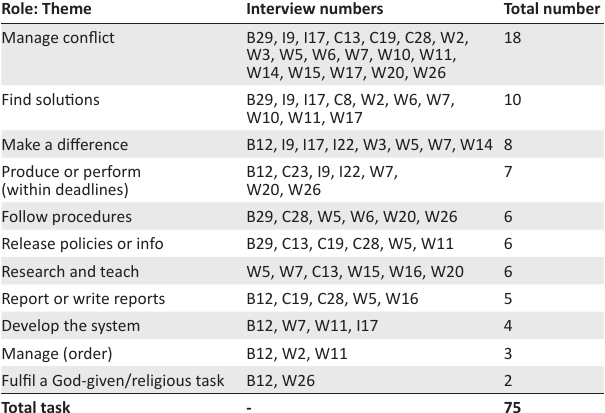
TABLE 9: Tasks of women leaders. Role: